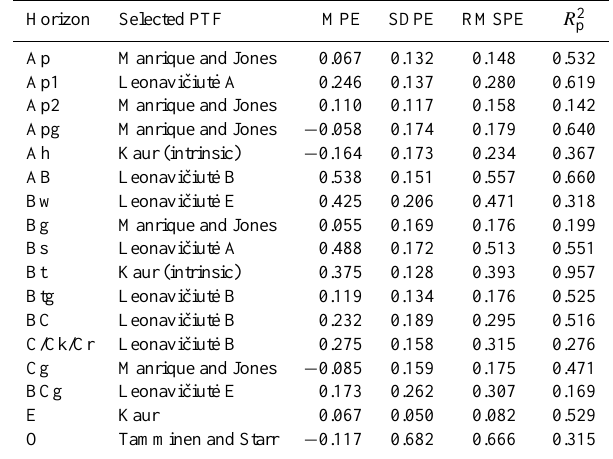
Table 6. The mean predicted error (MPE, gcm − 3 ); the standard deviation of the prediction error (SDPE, gcm − 3 ); the root mean squared prediction error (RMSPE, gcm − 3 ); and the prediction coefficient of determination ( R 2 p ) using complimentary prediction quality indices (De Vos et al., 2005) for each horizon type and se- lected pedotransfer function